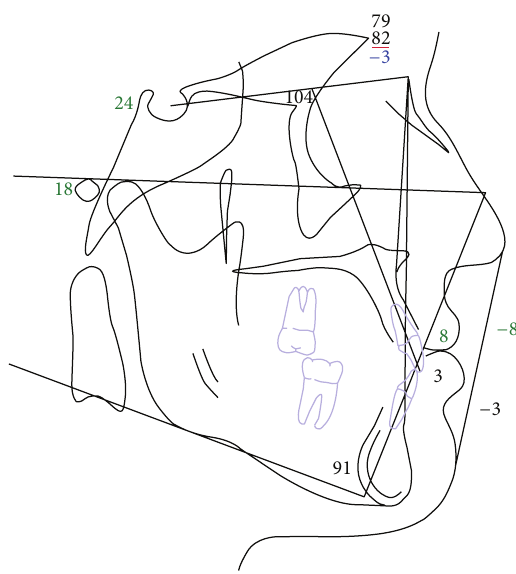
Figure 4: Initial lateral cephalometric tracing.